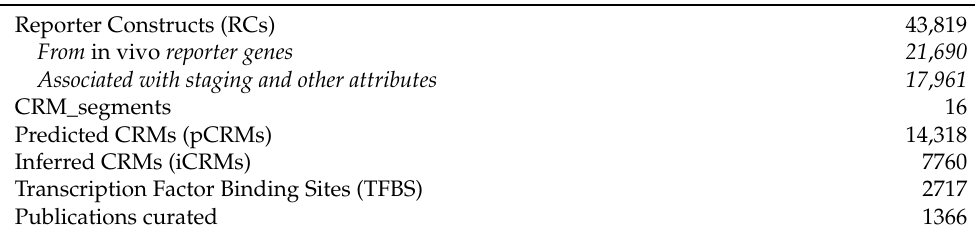
Table 1. REDfly contents as of 1 July